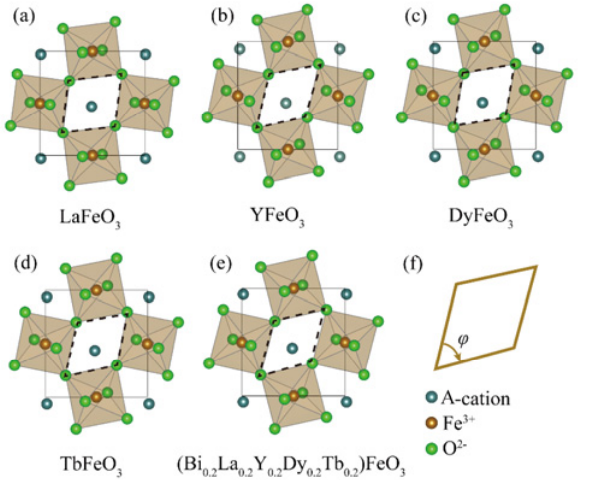
Fig. 5 Schematic diagrams of increasing magnitude of tilting FeO 6 octahedron observed in orthorhombic perovskite- type structure ceramics along [010] axis: (a) LaFeO 3 , (b) YFeO 3 , (c) DyFeO 3 , (d) TbFeO 3 , (e) BLYDTFO, and (f) quadrilateral of four oxygen atoms on different